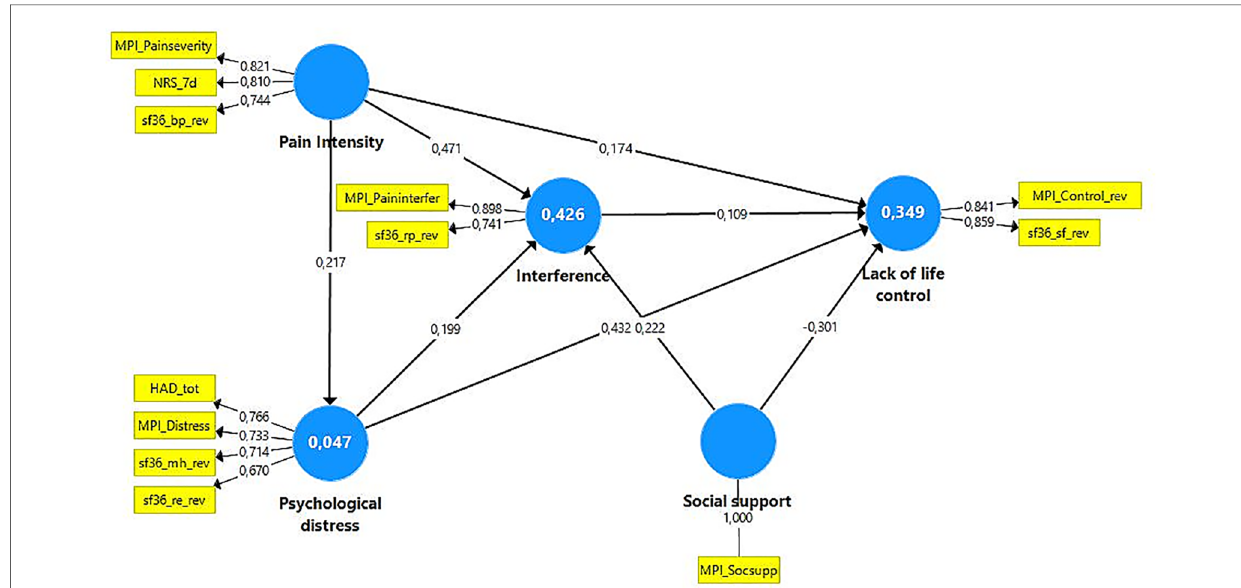
FIGURE 4 Model 2 (pain intensity affects psychological distress) for the subgroup with low distress ( N =20,986). The blue circles show the constructs. The yellow boxes show the indicators (re fl ective) for each latent variable; the fi gure attached to the thin arrows show the loading. The thicker arrows show the suggested relations between the constructs. The fi gure attached shows the path coef fi cient (direct effect). The explained variance ( R 2 ) is reported within the relevant constructs. Note that some of the MPI variables and all sf36 variables were revised (indicated with _rev in the variable name) so that high values indicated a troublesome/negative situation. NRS_7d, Pain intensity according to a numeric rating scale; HAD, The Hospital Anxiety and Depression Scale; HAD-tot, sum of the two subscales of HAD; MPI, Multidimensional Pain Inventory; MPI_Paininterfer, MPI Pain interference;